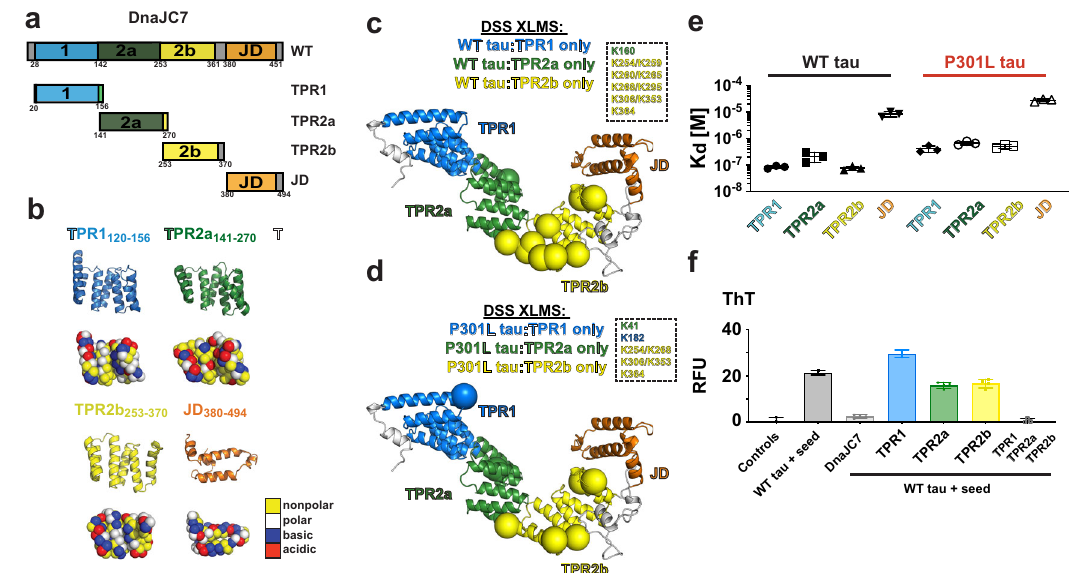
Fig. 5 Ef fi cient DnaJC7 suppression of tau aggregation relies on all three TPR domains. a Schematic diagram of DnaJC7 domain constructs used: TPR1 20- 156 (light blue), TPR2a 141-270 (dark green), TPR2b 253-370 (yellow), and JD 380-494 (orange). b Cartoon representation of TPR1 20-156 (light blue), TPR2a 141-270 (dark green), TPR2b 253-370 (yellow), and JD 380-494 (orange) oriented to highlight the peptide binding groove. Space fi ll representation of each domain is colored according to amino acid properties; polar (white), nonpolar (yellow), acidic (red), and basic (blue) residues. c , d The major cross-link sites derived from the WT tau and P301L tau bound to individual TPR domains: TPR1 (blue), TPR2a (green) and TPR2b (yellow). We observe one cross-link from WT tau to TPR2a (green) and nine cross-links to TPR2b (yellow). For P301L tau, we detected one cross-link to TPR1 (blue) and one to TPR2a (green) and four cross- links to TPR2b. DnaJC7 homology model shown in cartoon representation and the domains are colored as in (Fig. 2). The cross-link sites are shown as spheres and colored by the domain. e MST-binding af fi nity summary of TPR construct binding to WT tau and P301L tau. Binding experiments were performed as technical triplicates and fi tted to a linear-regression curve to estimate binding constants. The derived binding constants are shown as the mean with standard deviations across replicate experiments ( n = 3). WT tau and P301L tau binding experiments are shown in black and red, respectively, and the TPR labels are colored according to the TPR domain as in ( a ). f Individual TPR domains were used in a ThT fl uorescence aggregation assay to measure their effect on suppressing tau aggregation in vitro. The end point of each experiment is shown as a barplot and colored according to the TPR domain in ( a ). The in vitro aggregation experiments were performed as technical replicates ( n = 3) and the data are reported as a mean with standard